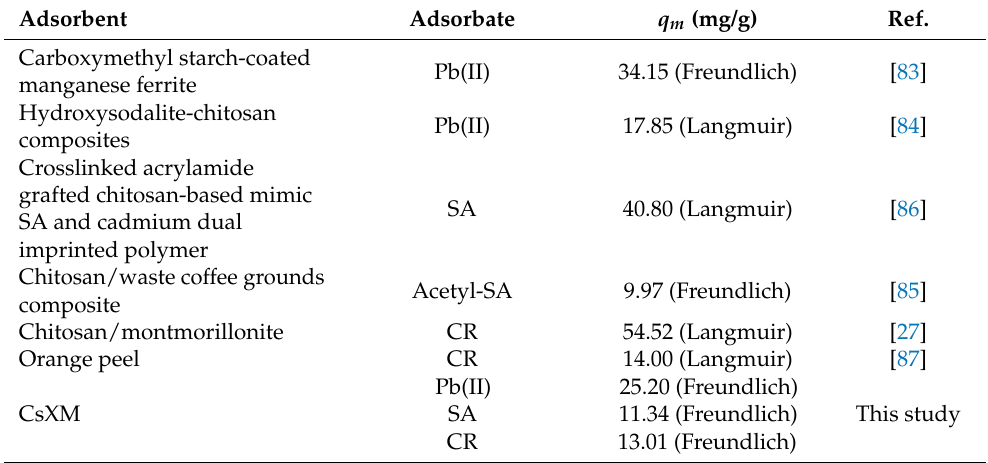
Table 6. Comparison of CsXM adsorption capacities with those of other bio-based adsorbents previously reported in the